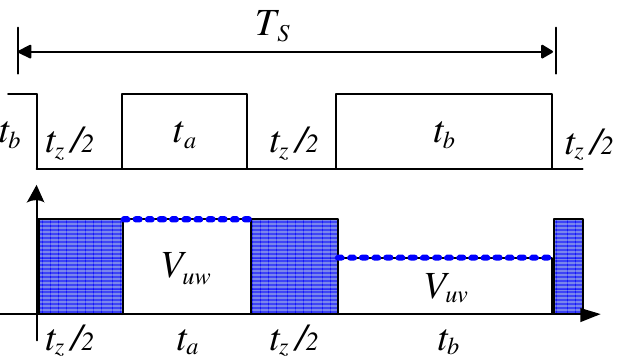
Figure 5. Evolution of v cmZC (lower trace in blue) during a switching period in case of ASVM (active vectors during t a and t b , zero vector during t z ). v cmZC evolution with ideal power devices in black trace, and with real power devices in red trace.